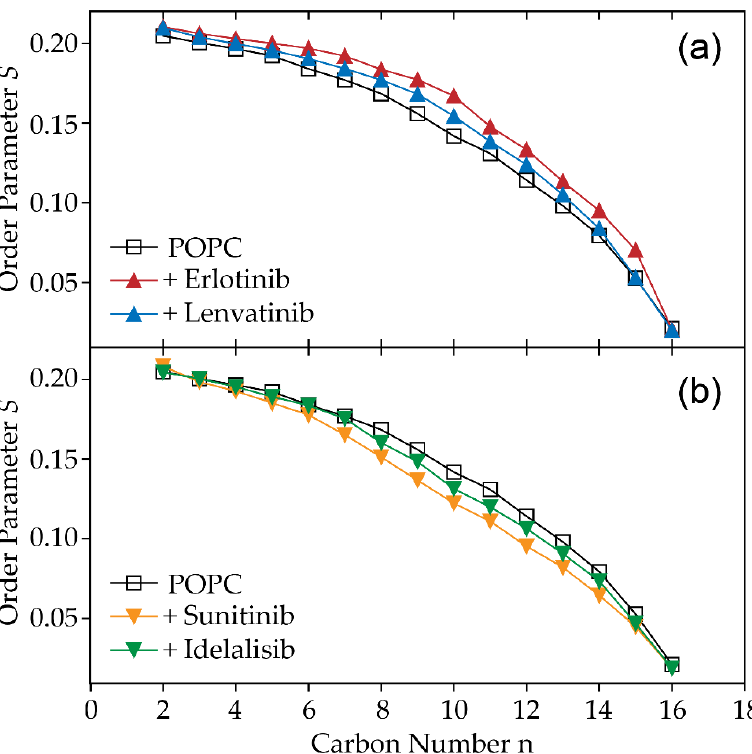
Figure 3. 2 H NMR smoothed order parameter profiles of the sn -1 chain perdeuterated analogue of POPC (POPC- d 31 ) both in the absence and in the presence of 20 mol% of each of the inhibitors. While lenvatinib and erlotinib ( a ) raise the order parameter, indicating stiffening of the membrane, idelalisib and sunitinib ( b ) lower the order parameter along the chain. Table 1. The 31 P NMR chemical shift anisotropy (CSA), the average 2 H NMR order parameter <S>, and the calculated chain length L C * of the POPC sn-1 acyl chain for pure POPC- d 31 and for POPC- d 31 in the presence of the respective